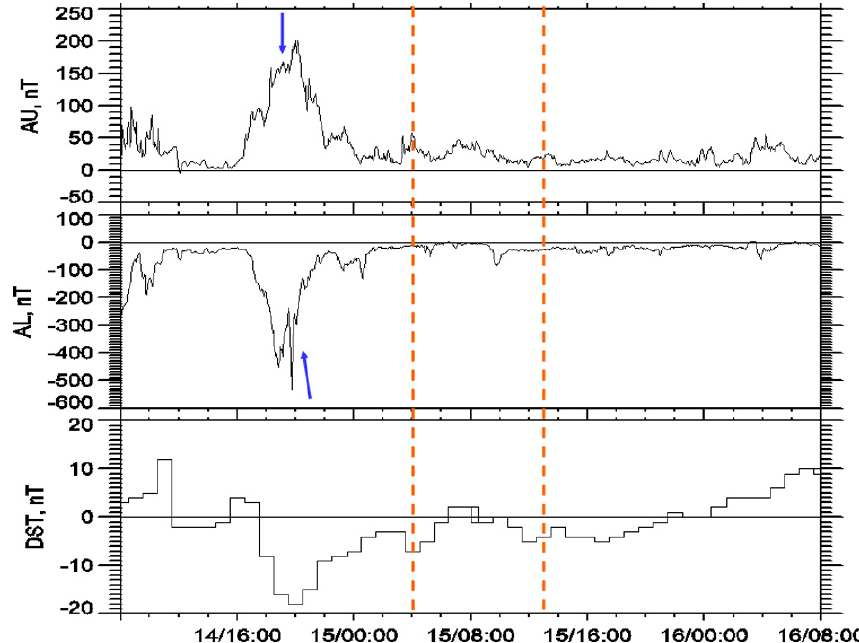
Fig. 4. AE (top panel), AU (middle panel) and Dst (bottom panel) indices evolution between the 14 May at 08:00UT and the 16 May 2009 at 08:00UT. The orange dashed lines are located on 15 May at 04:00UT and at 13:00UT and delimitate the time range of the magnetic field data presented in Fig. 3. The blue arrows indicate variations of the auroral